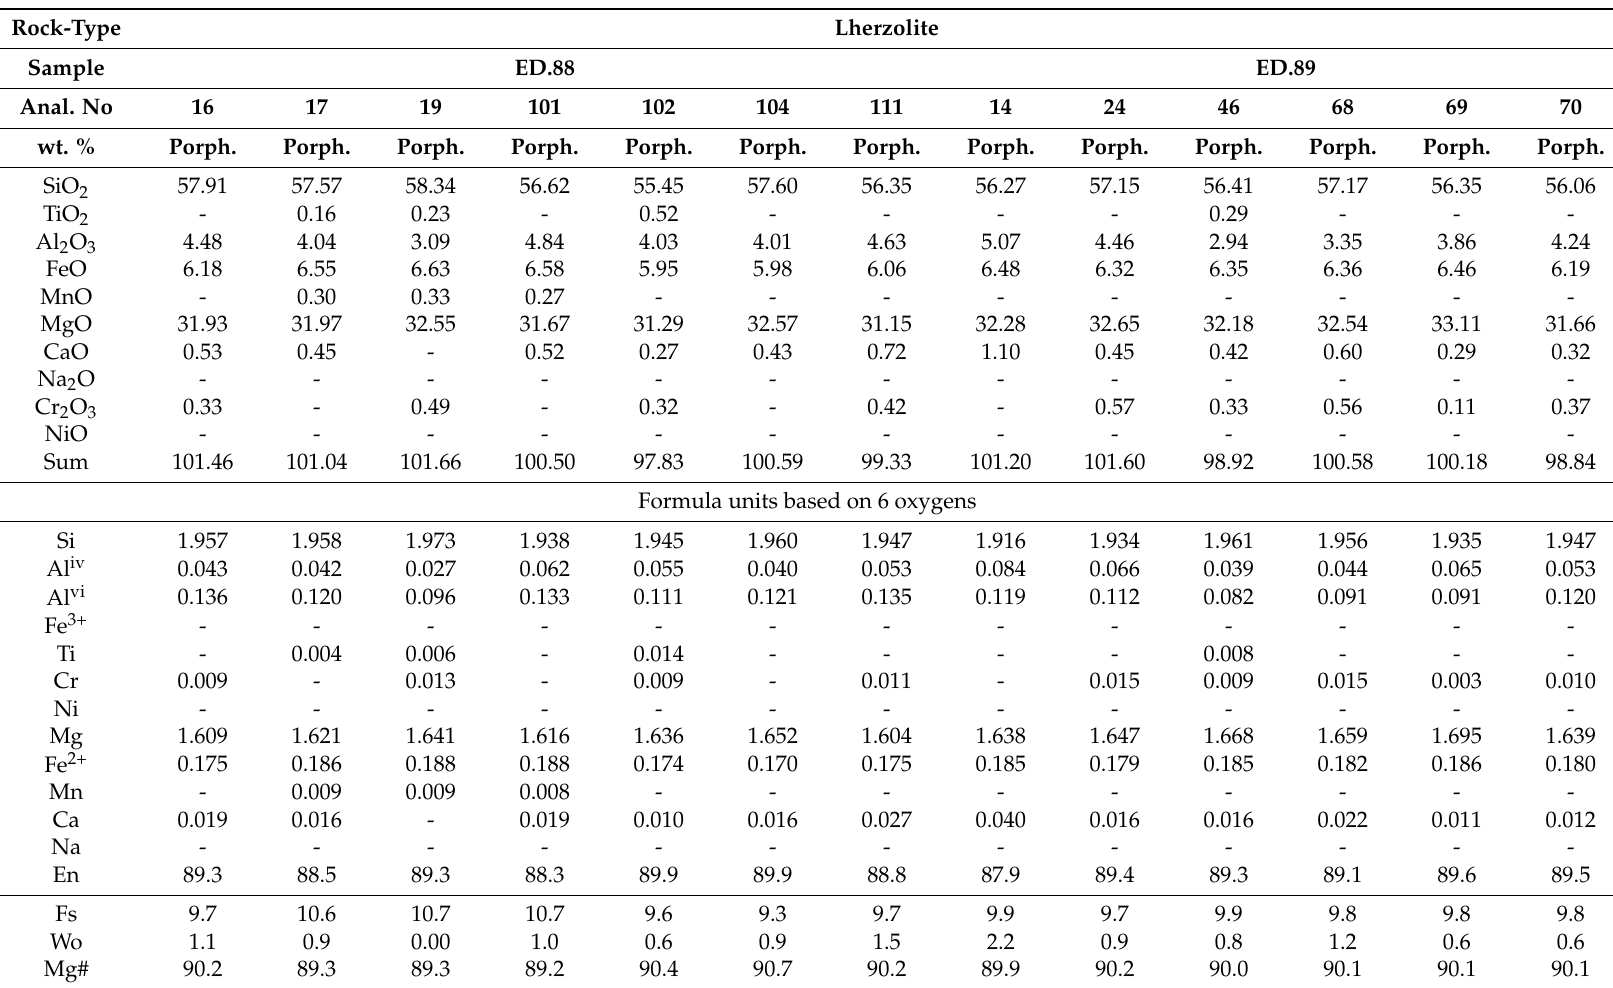
Table 3. Representative electron microanalyses of porphyroclastic orthopyroxenes from lherzolite of the Edessa ophiolitic complex (-: below detection limit).